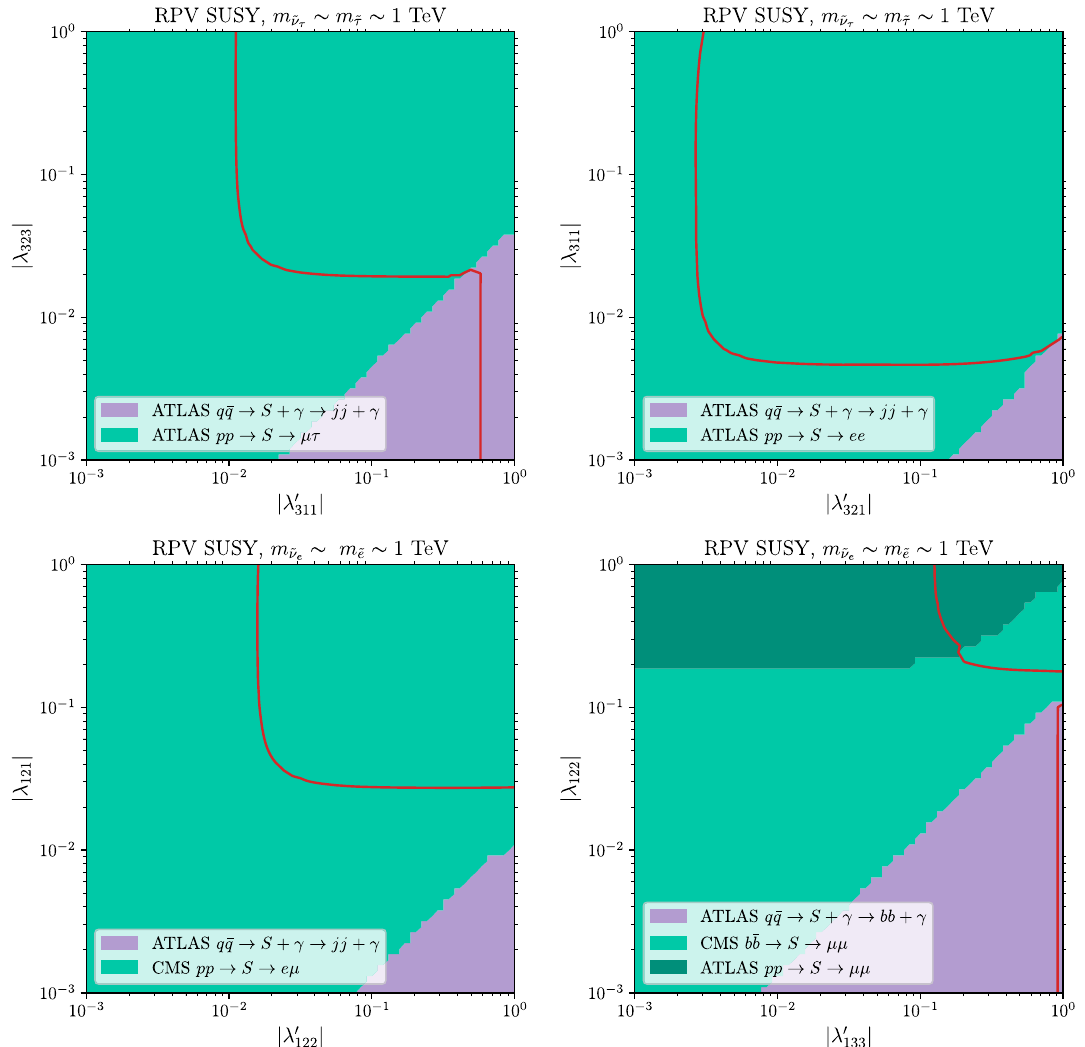
Fig. 6 Limits from searches for a scalar resonance decaying to two jets or two leptons in the R -parity violating MSSM. The color code indicates the most sensitive limit for each parameter point. The red line indicates the exclusion limit set by